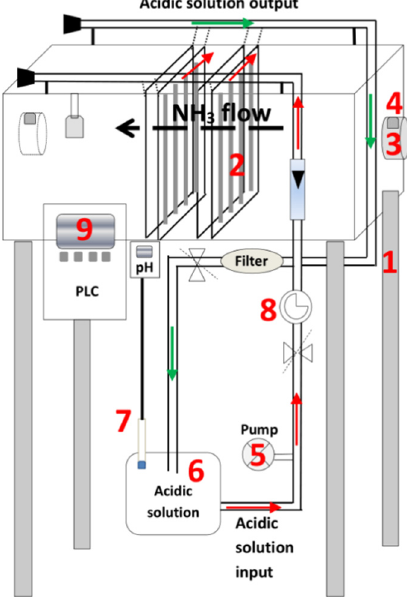
Figure 3. Schematic of the gas-capture